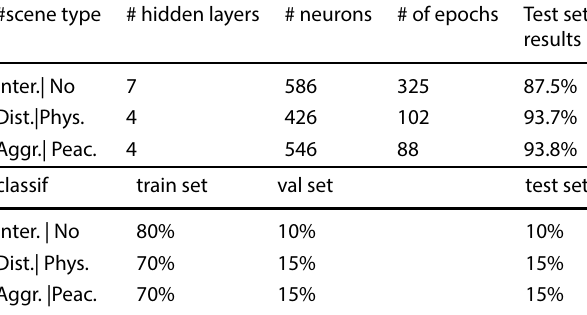
Table 3 Used datasets